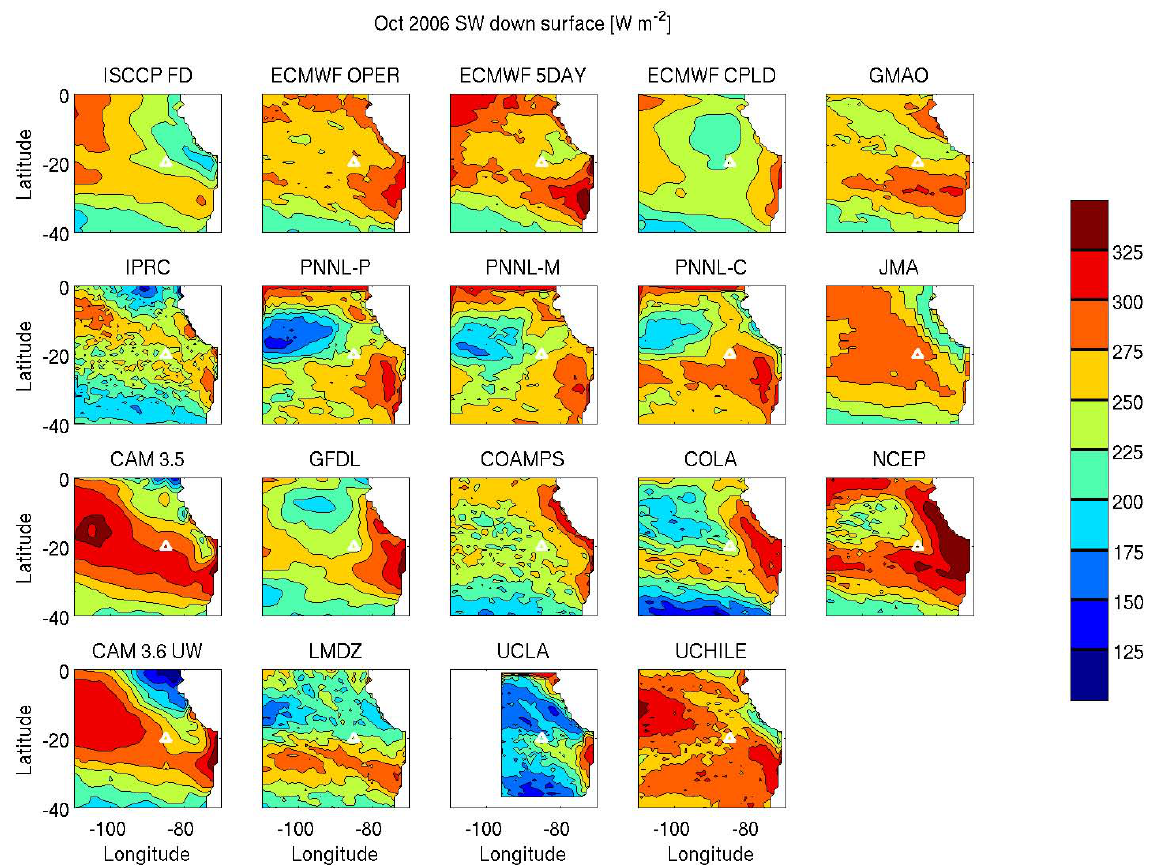
Fig. 6. October 2006 mean downwelling SW radiation at the surface from ISSCP and models (Wm − 2 ).